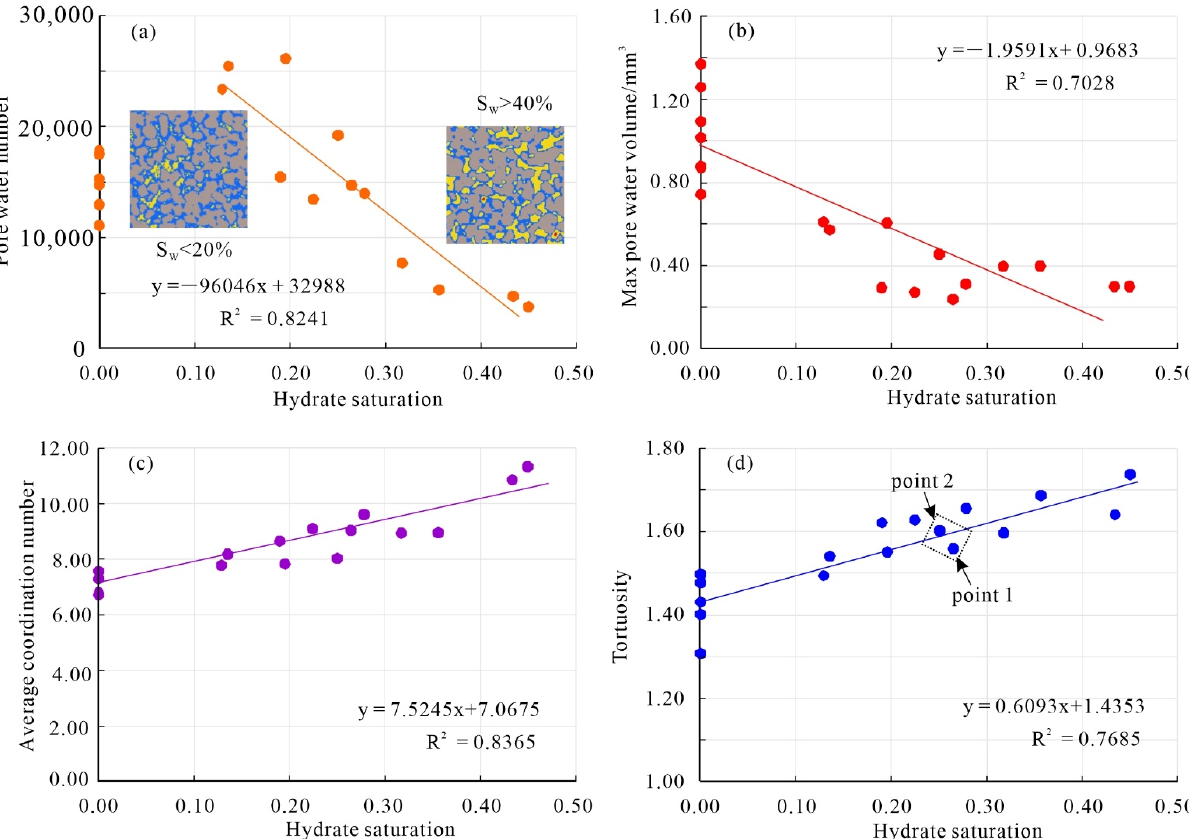
Figure 5. The geometrical factors of pore water versus hydrate saturation, and the linear relationship between hydrate saturation and geometrical factors of pore water, including pore water number in ( a ), maximum pore water volume in ( b ), average coordination number in ( c ) and tortuosity in ( d ). R 2 is the correlation coefficient of the linear relationship.